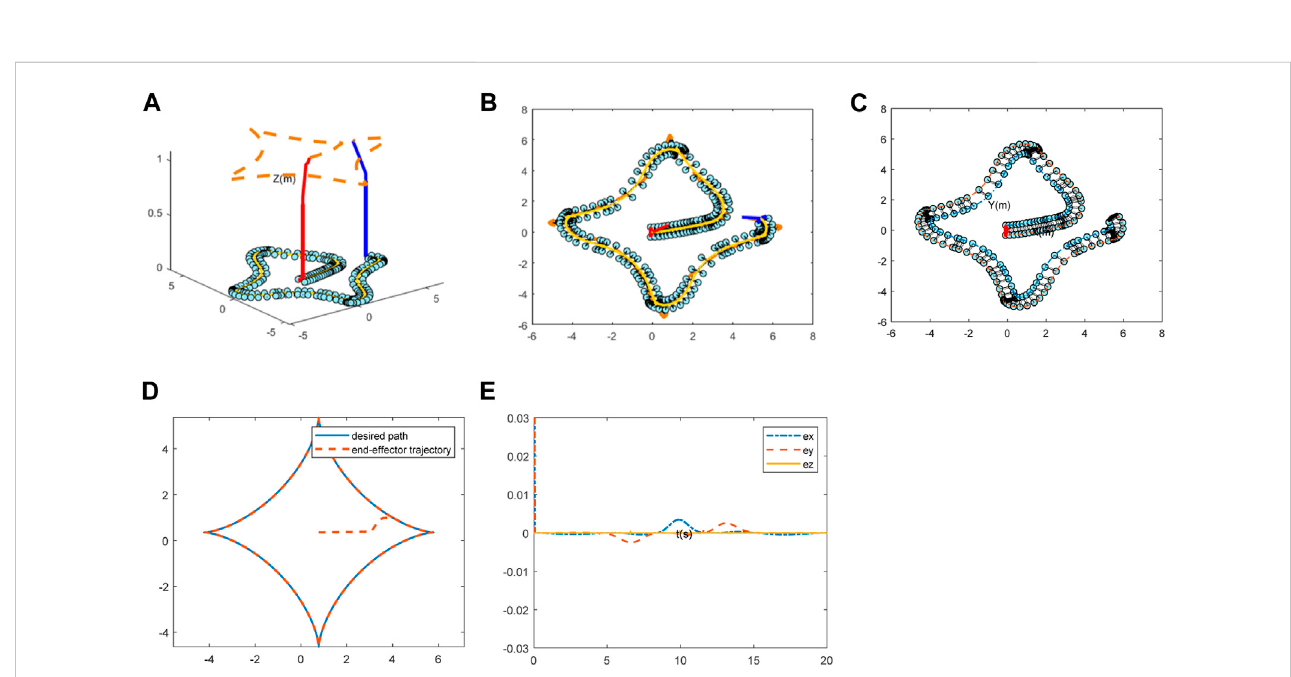
FIGURE 5 Simulations of mechanical arm tracking trajectory: (A) The whole track schematic; (B) Top plot of the traced trajectory; (C) Movement trajectory of the mobile platform; (D) Expected path and actual trajectory contrast; (E) Tracking